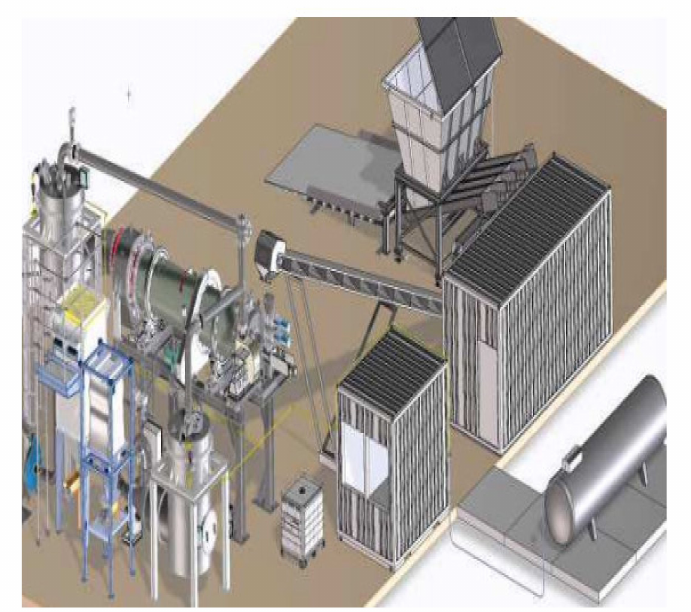
Figure 1. Euphore-type thermochemical treatment